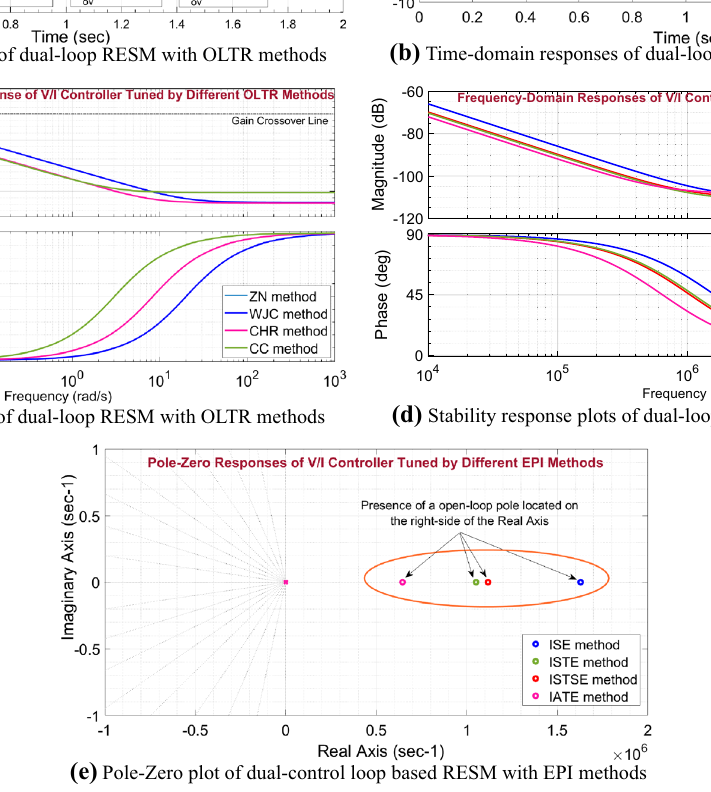
Fig. 12 Response of the dual-control loop system (V/I controller based RESM) with conventional OLTR and EPI